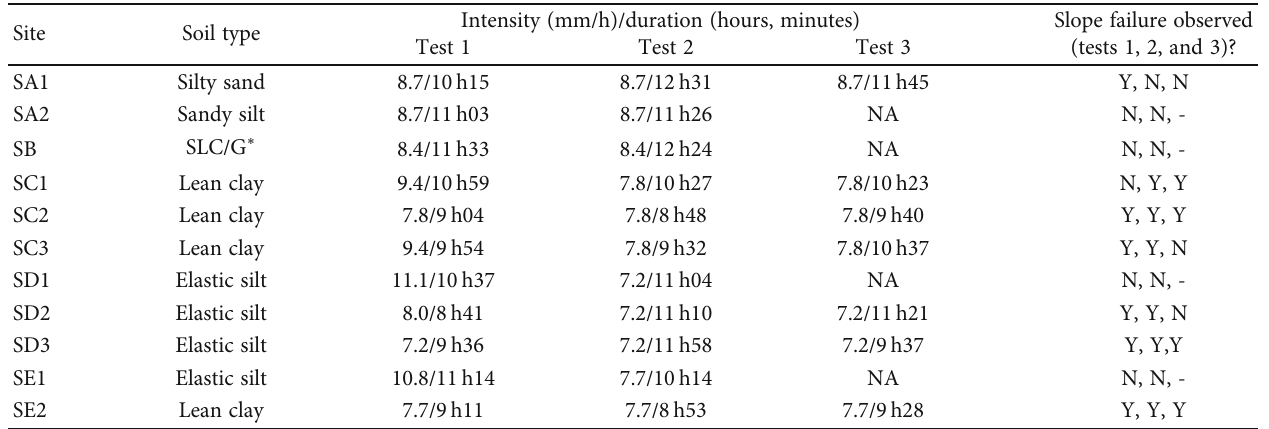
Table 4: Observed simulation